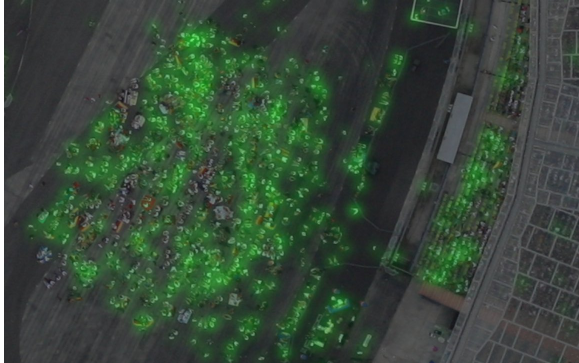
Figure 7: Estimated crowd density (High image intensities corre- spond to high crowd